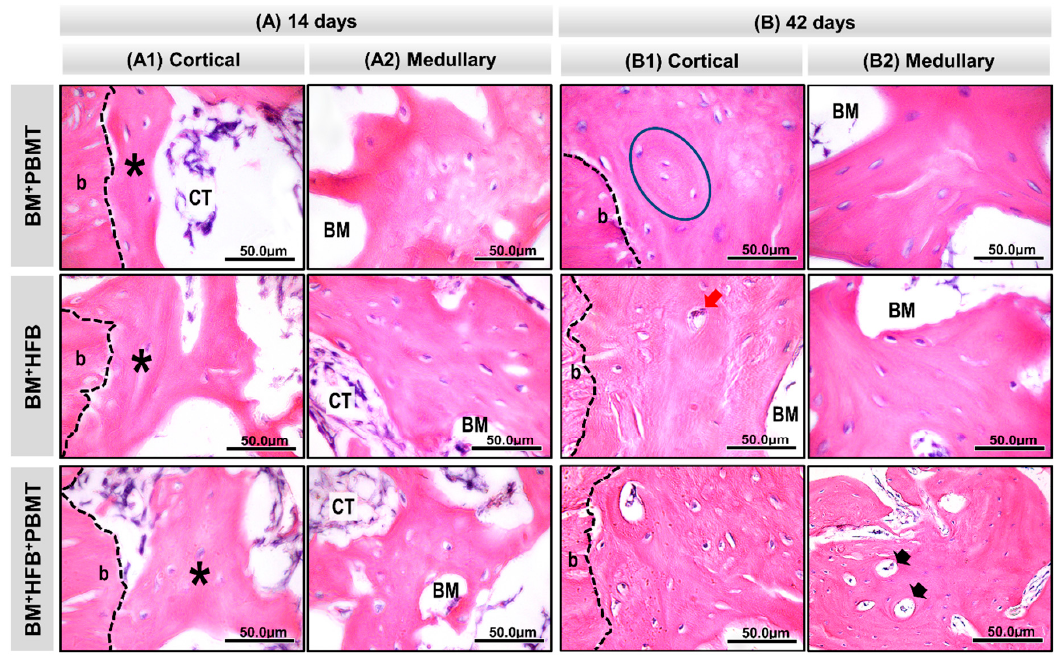
Figure 5. Time course of monocortical defect healing in rats tibia in groups: Group 1 (BM + PBMT) (defects filled with lyophilized bovine bone matrix (xenograft) with photobiomodulation therapy), Group 2 (BM + HFB) (defects filled with lyophilized bovine bone matrix plus heterologous fibrin biopolymer) and Group 3 (BM + HFB + PBMT) (defects filled with lyophilized bovine bone matrix plus heterologous fibrin biopolymer with photobiomodulation therapy) in the periods of 14 and 42 days. ( A ) At 14 days. ( A1 ) In cortical area, all experimental groups show bone growth (asterisks) from the border of the defect (b) with immature trabecular conformation surrounded by connective tissue (CT). ( A2 ) In the medullary area, for BM + PBMT, BM + HFB and BM + HFB + PBMT, fine bone trabeculae are noted around particles of the biomaterial (BM). ( B ) At 42 days. ( B1 ) In the cortical area, increased bone formation in the bone defect border, presence of concentric laminae (inside the blue lined area) in Group 1 (BM + PBMT) and the blood vessel (red arrow) in Group 2 (BM + HFB) are observed. ( B2 ) In the medullary area, the bone trabeculae are thicker and more compact with Haversian canals (black arrow) in Group 3 (BM + HFB + PBMT), in relation to the previous period with some biomaterial particles in all groups. (HE; original 100 × magnification; bar = 50 µm).